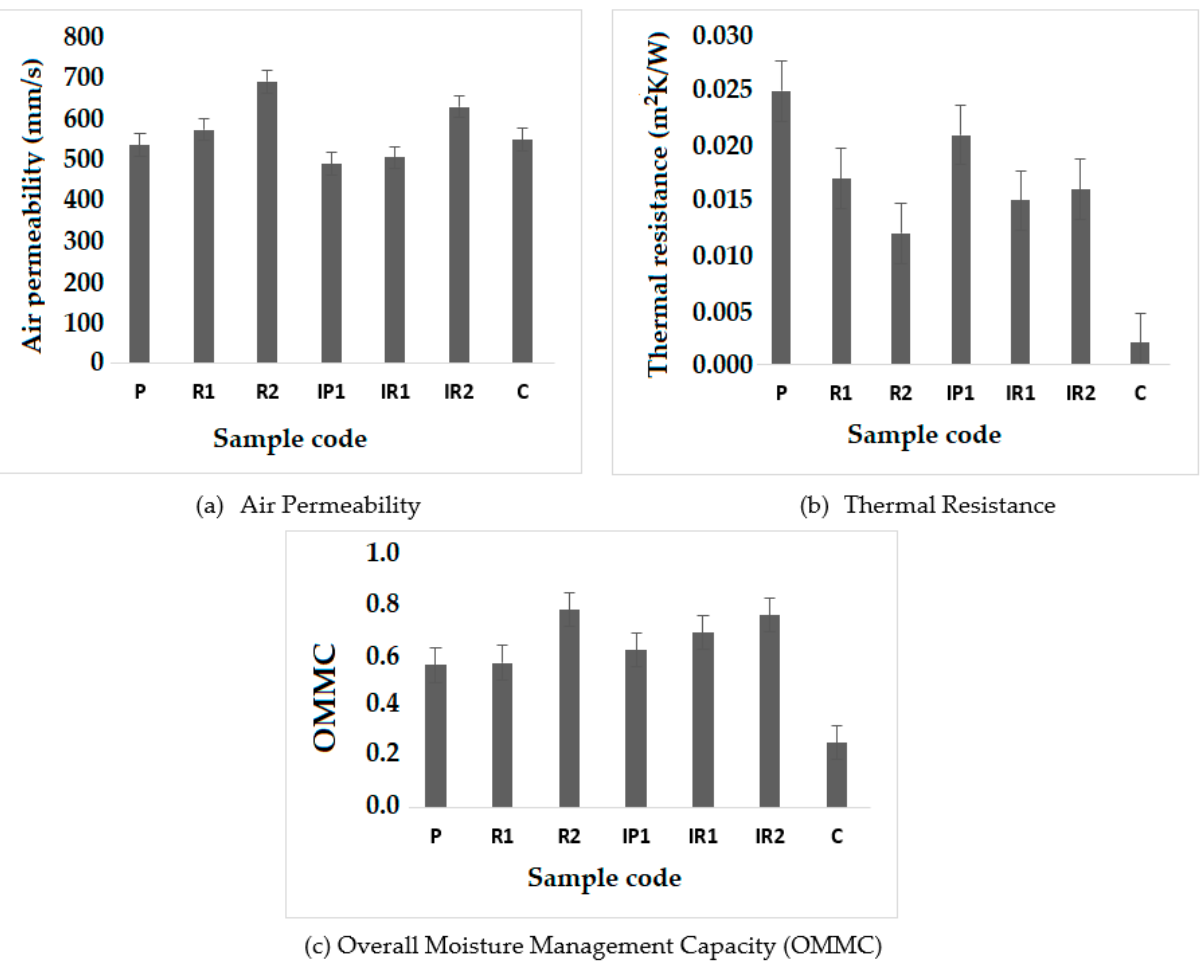
Figure 8. Thermo-phycological comfort properties of the developed stockings.